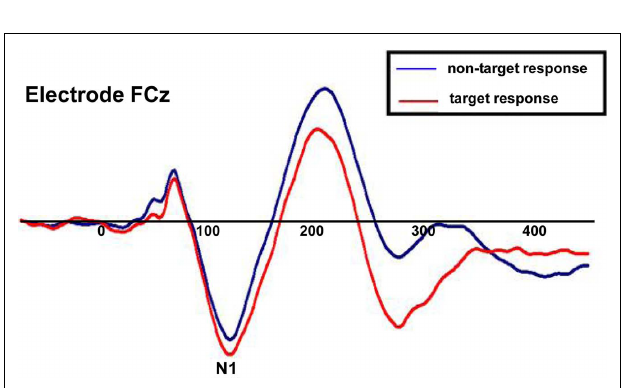
FIGURE 7 | Group-averaged waveforms for responses to the sound object recognition ( WHAT ) task for target stimuli (red) versus non-target stimuli (blue). Representative electrode shown is